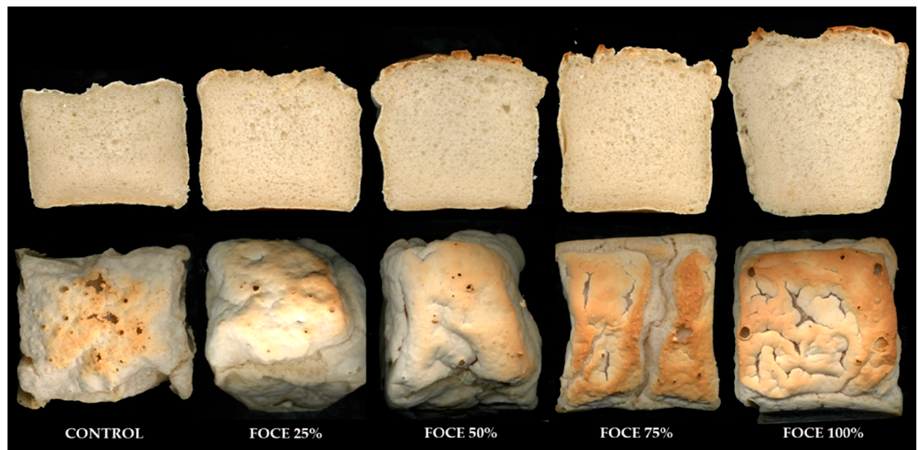
Figure 3. The exemplary pictures of the appearance of cross-section and surface of the experimental gluten-free breads with FOCE replacing water. gluten-free breads with FOCE replacing